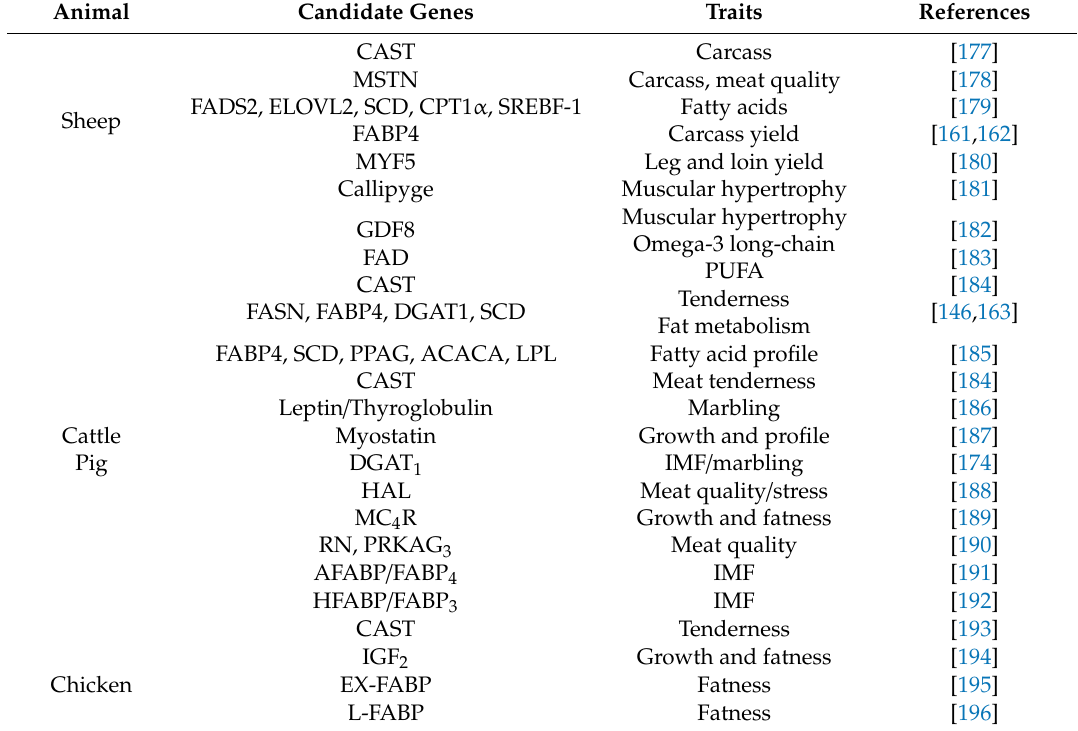
Table 2. Candidate genes associated with meat quality traits in